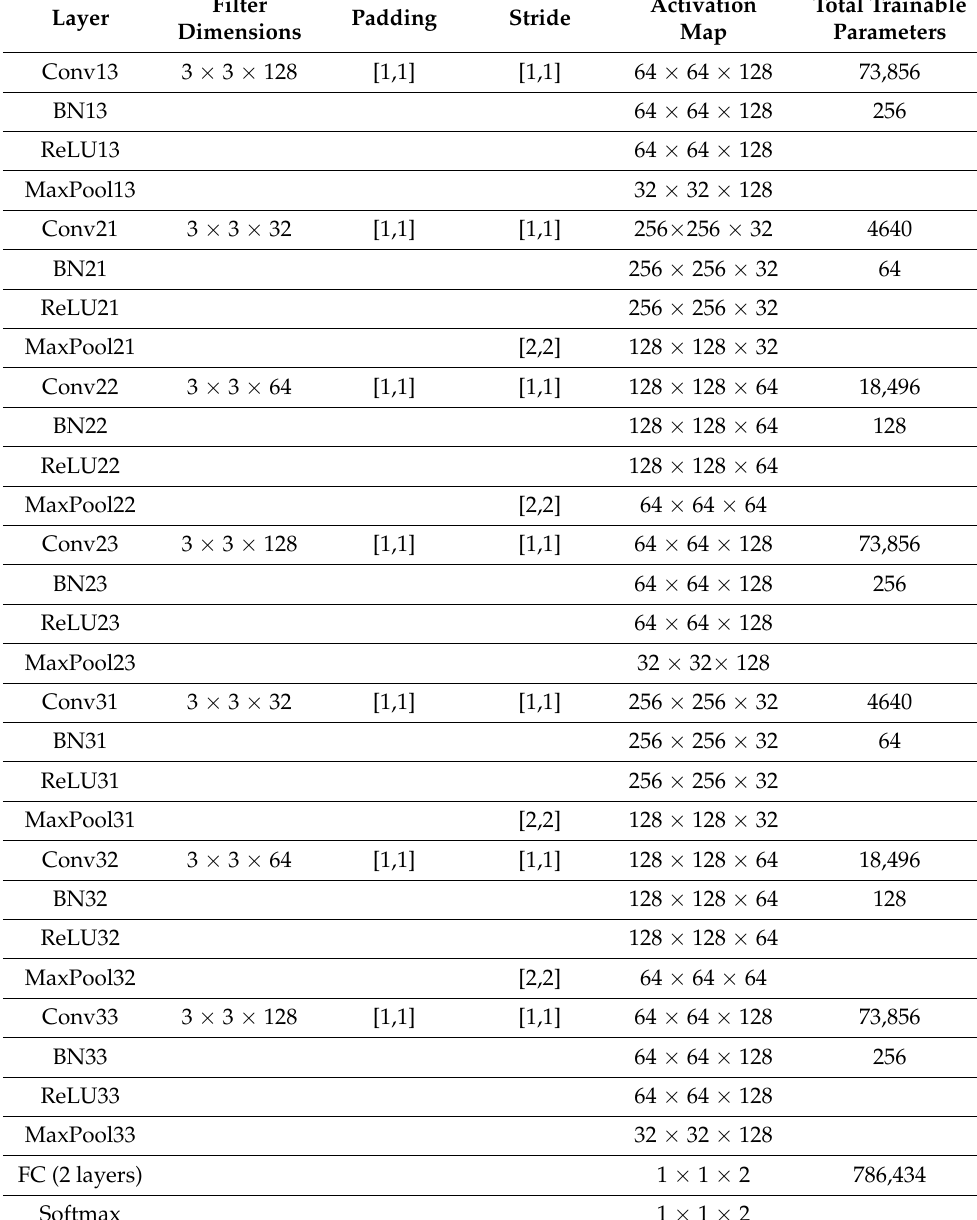
Table 1. Cont. Filter Layer Dimensions